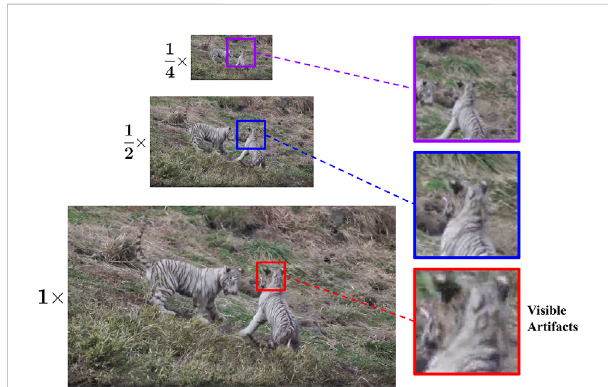
FIGURE 1 Video quality is affected by both global video composition and local details. Although downsampled video frames provide the global view and are easier to process for deep-learning models, some distortions visible on the original high resolution videos may disappear when resized to a lower resolution.